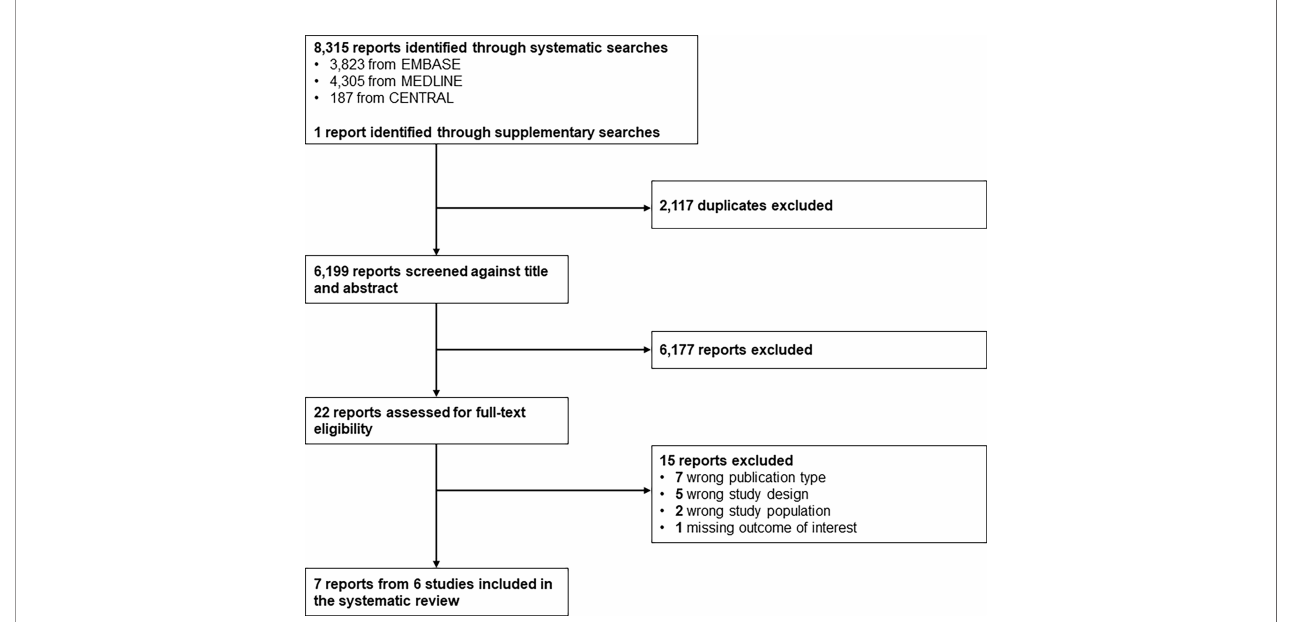
FIGURE 1 | Study selection fl ow. CENTRAL, Cochrane Central Register of Controlled Trials; EMBASE, Excerpta Medica database; MEDLINE, Medical Literature Analysis and Retrieval System